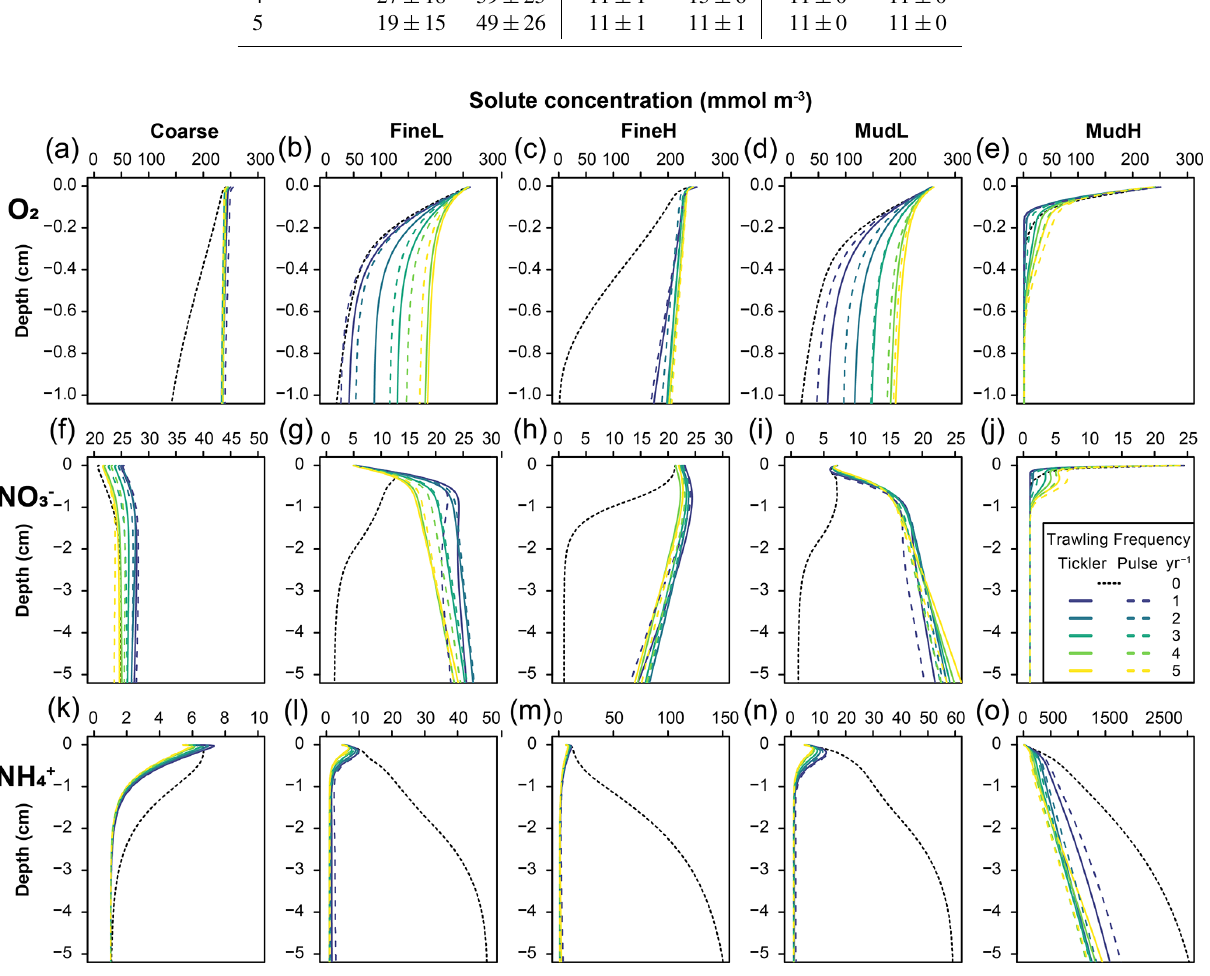
Figure 4. Annually averaged modelled concentrations (mmolm − 3 ) of oxygen (a–e) , nitrate (f–j) , and ammonium (k–o) in the different types of sediment used as the basis for the disturbance simulations (columns). The black dotted line is the 0 trawl default, and the full and dotted coloured lines are tickler and pulse gear respectively, with increasing trawling frequencies as different